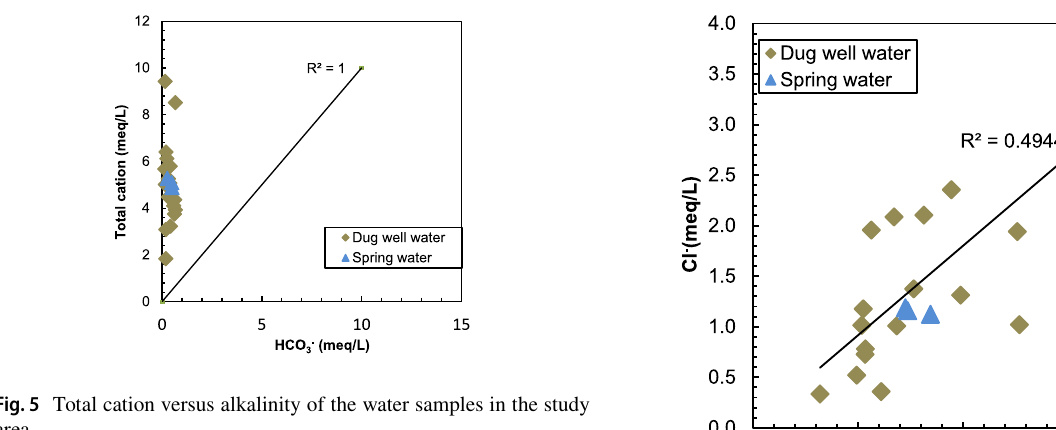
Fig. 5 Total cation versus alkalinity of the water samples in the study area